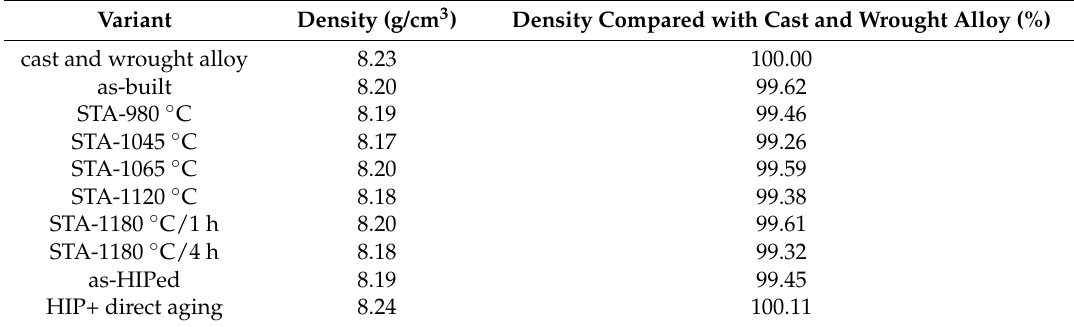
Table 3. Comparisons of density between post-processed materials and cast and wrought alloys. Variant Density (g/cm 3 ) Density Compared with Cast and Wrought Alloy (%) cast and wrought alloy